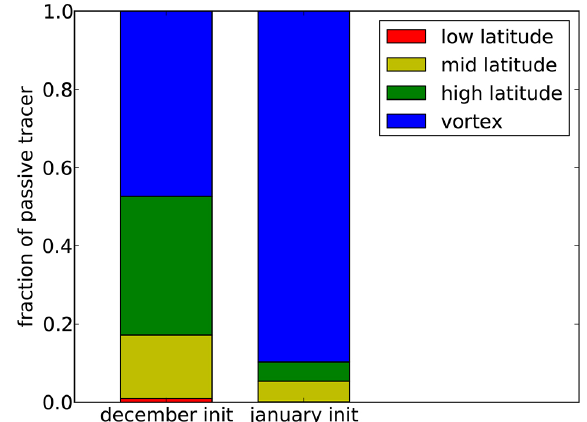
Fig. 8. Fraction of passive tracers for low-latitude, mid-latitude, high-latitude and vortex air masses inside the polar vortex (10:05 to 11:00UTC) around flight altitude ( ≈ 450K potential temperature) for December and January